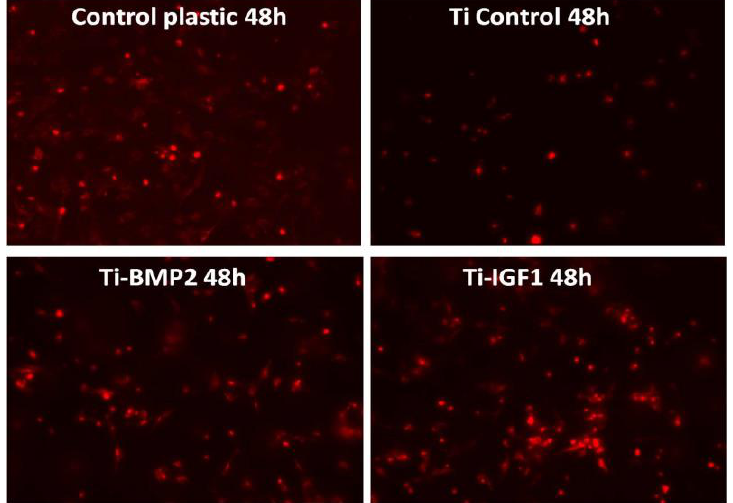
Figure 10. Cells with red fluorescence at the surface of the plastic wells and of the titanium discs